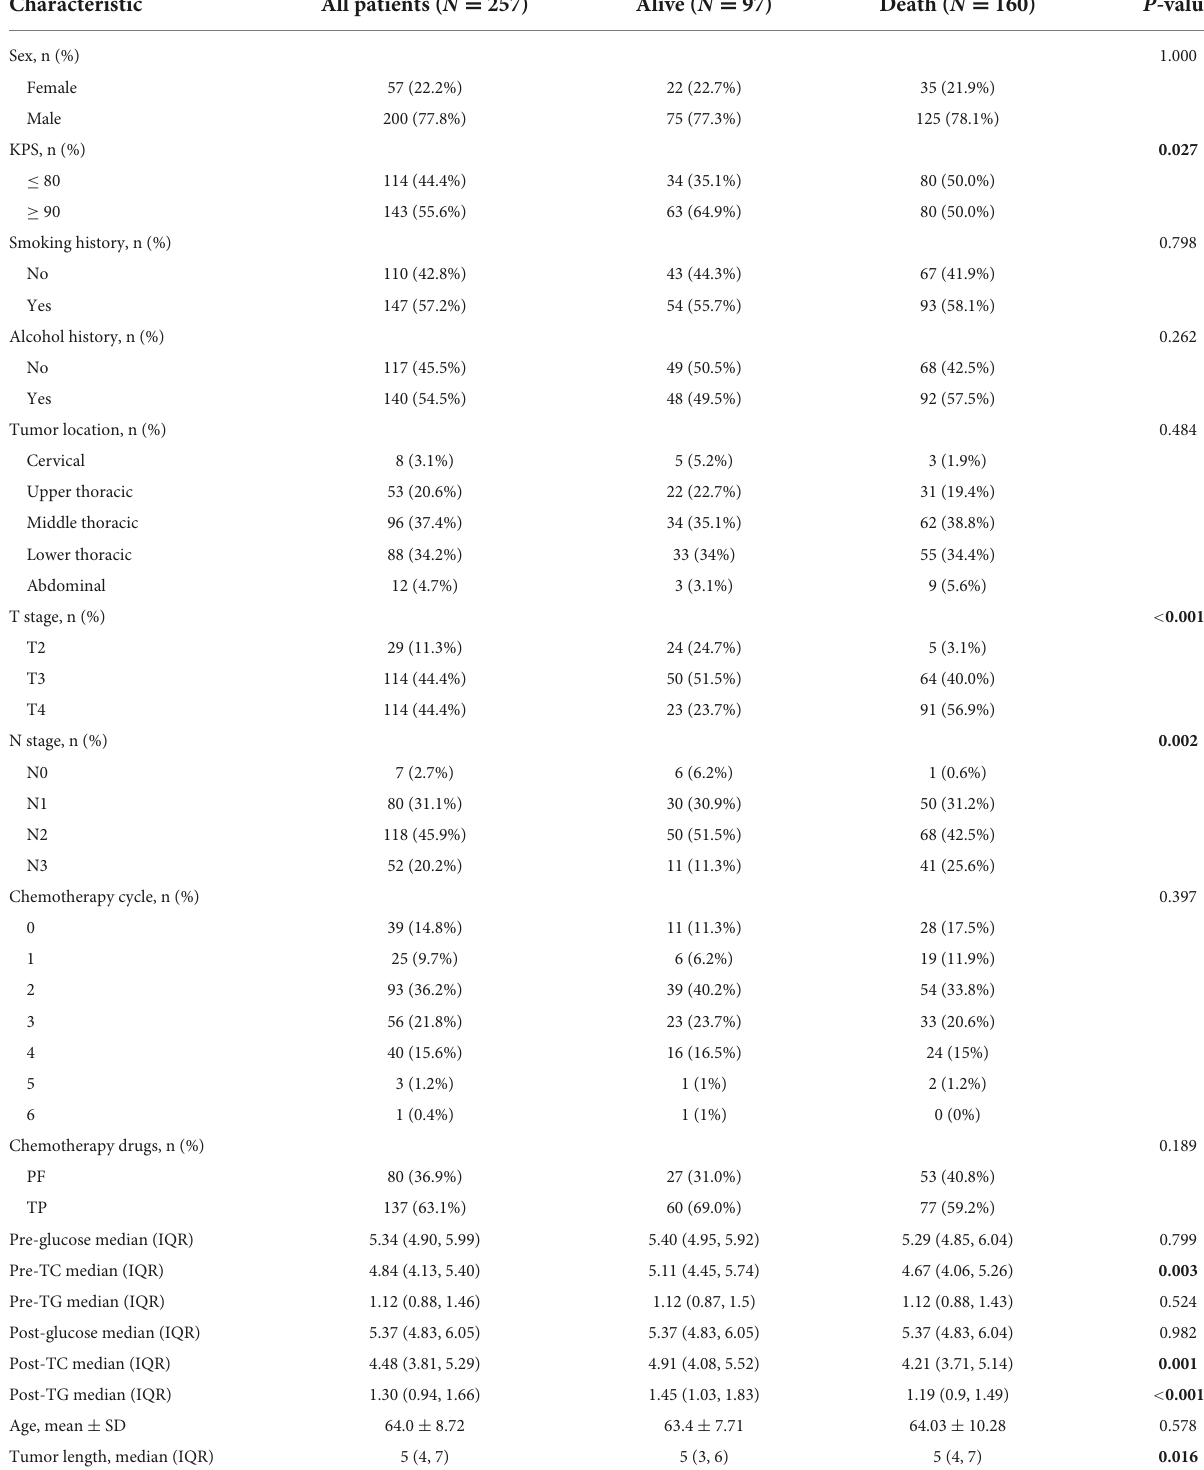
TABLE 1 The distribution of background variables stratified by survival